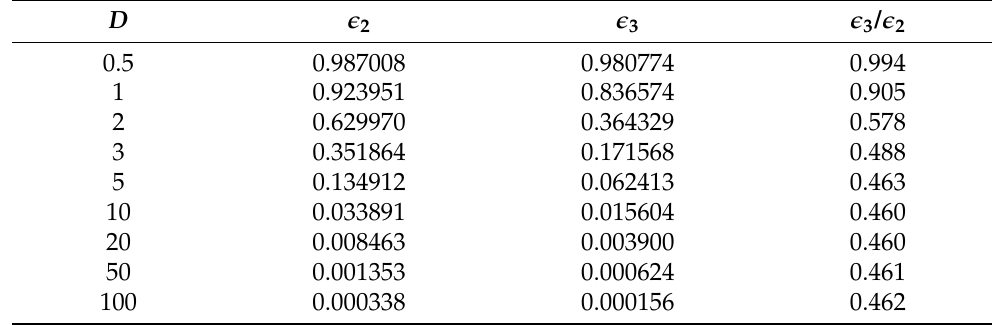
Table 3. Effect of increasing D on the largest non-trivial diffusion operator. Here, (cid:101) 2 is the largest non-trivial eigenvalue and (cid:101) 3 the second largest. The density threshold coefficient, β min , was 0.2 in all cases and the number of required gridpoint samples at each timestep was